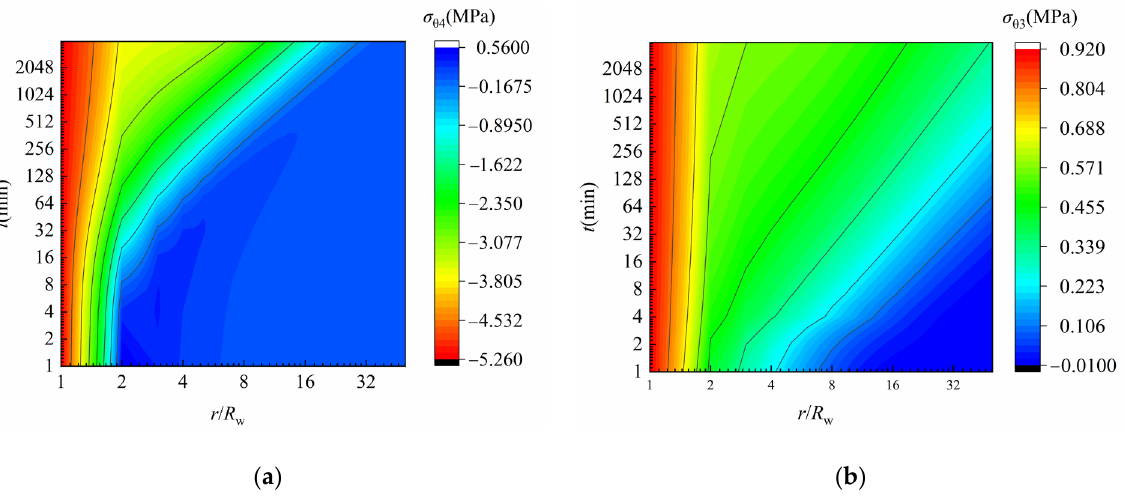
Figure 6. Change in elastic stress coefficient and fracture initiation pressure with Poisson’s ratio. ( a ) Elastic stress coefficient; ( b ) fracture initiation pressure.